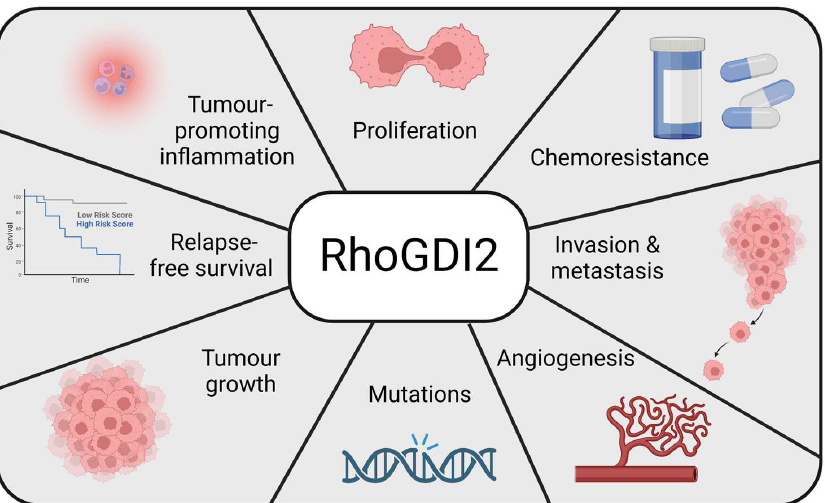
Figure 6. RhoGDI2 is involved in many hallmarks of cancer. RhoGDI2 is involved in many aggressive phenotypes of cancers via its regulation of Rho GTPases either directly or indirectly by interacting with other regulators of Rho GTPases. It modulates cell proliferation, tumour growth, cell migration, invasion and metastasis. It also provides chemoresistance and is shown to be mutated in some human cancers. It also contributes to tumour-promoting inflammation, angiogenesis and relapse-free survival in multiple human cancers. Created with BioRender.com (accessed on 28 January